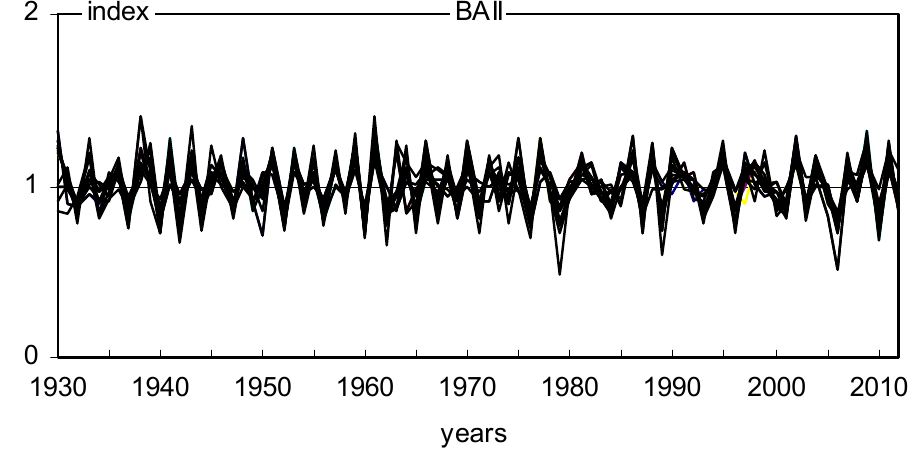
Figure 6. Eighteen site chronologies of basal area increment.